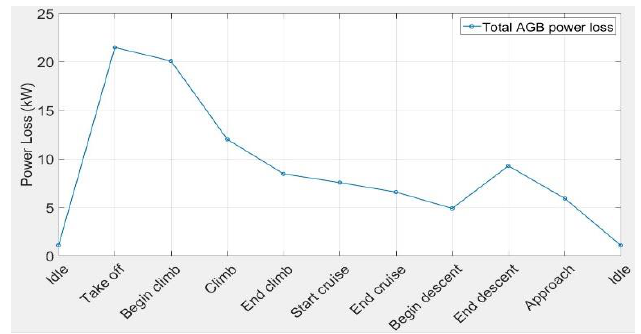
Figure 9. Overall power loss in AGB.